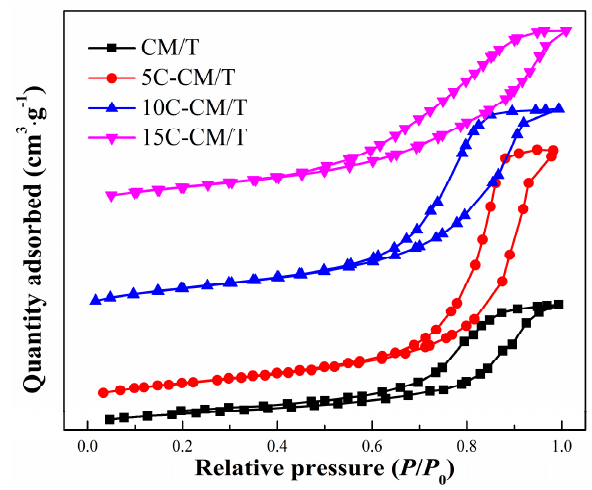
Figure 5. N 2 adsorption and desorption curves of different catalysts.